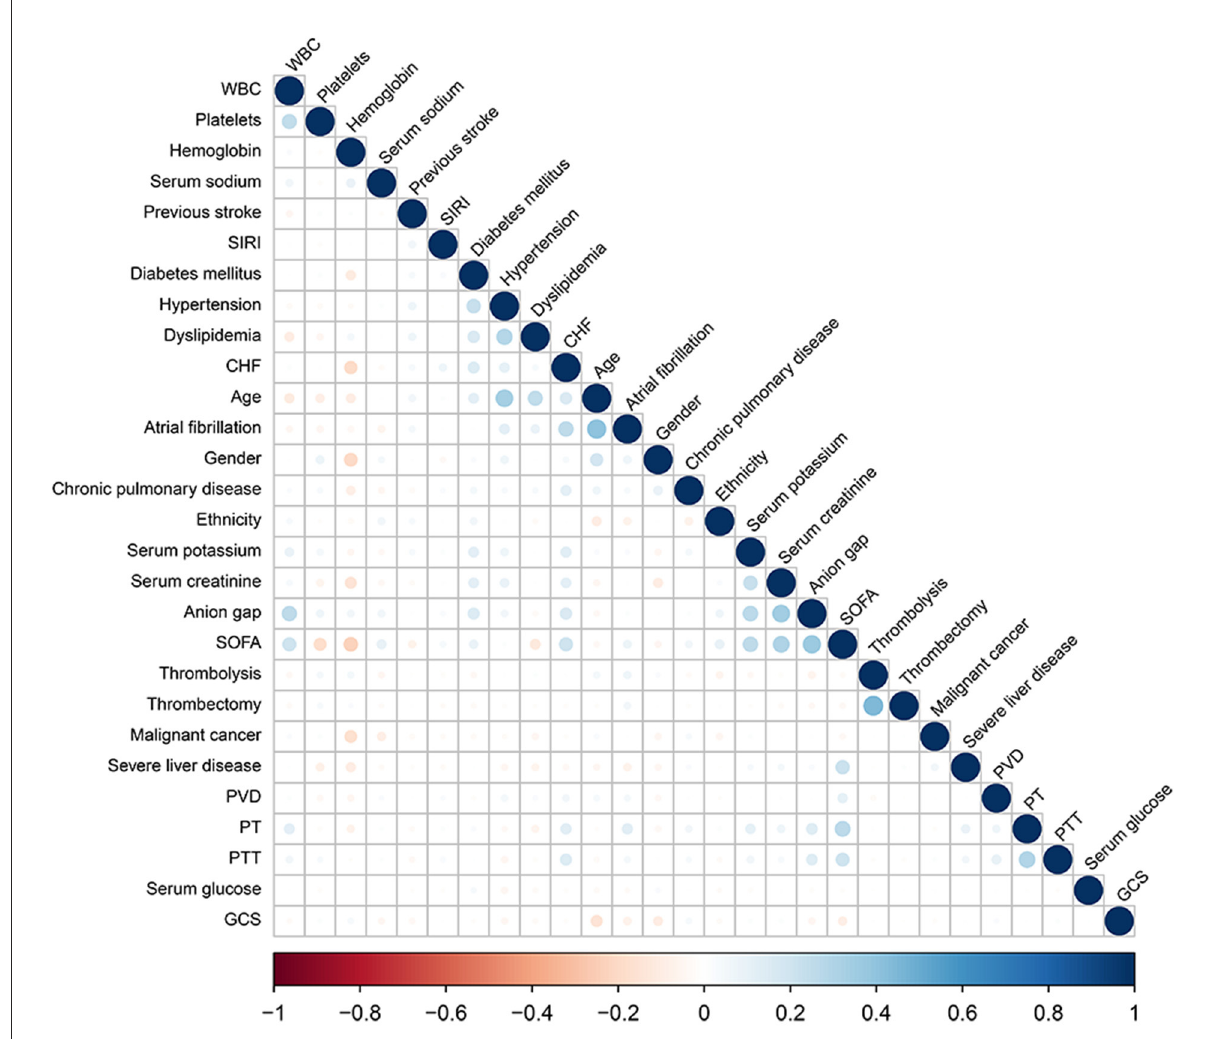
FIGURE2 Correlation coefficient between the variables. A color scale represents positive correlation (in blue) to negative correlation (in red). The size of the circle represents the absolute values of correlation